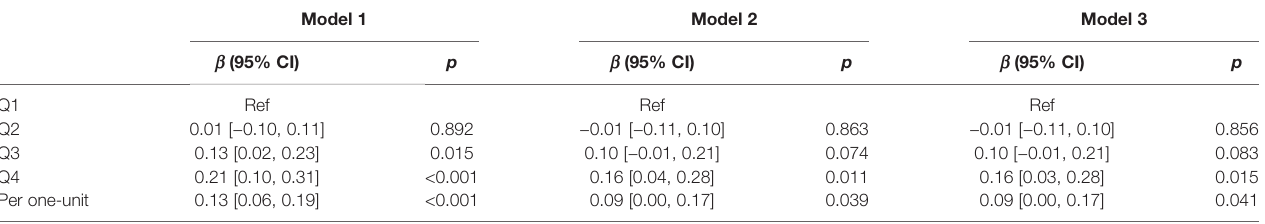
TABLE 2 | Multivariable linear regression between C-peptide and log2-CIIS.